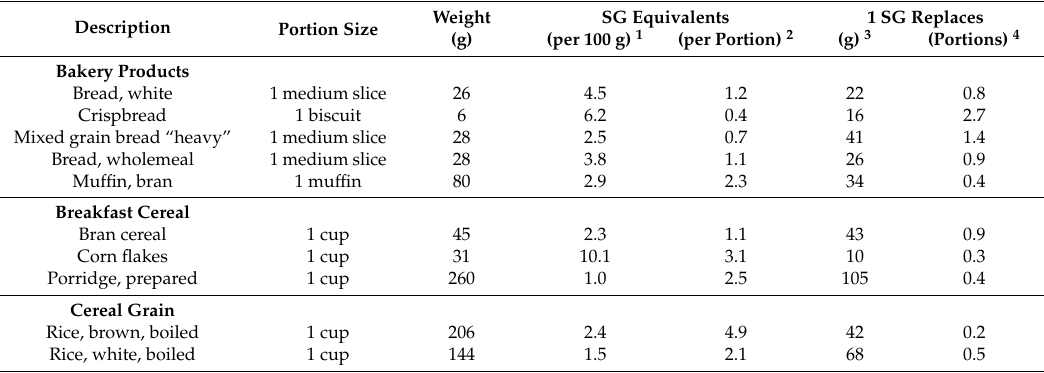
Table 3. Equi-glycemic kiwifruit exchanges based on the relative glycaemic potency of Zespri ® SunGold Kiwifruit (SG) and a selection of carbohydrate foods for which relative glycaemic potency (RGP) could be estimated from GI and available carbohydrate as grams of glucose equivalents (GGEs)/100 g, to maintain a constant glycaemic